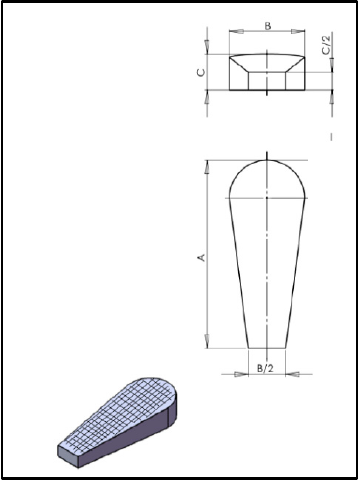
Figure 2. Implant sketch.